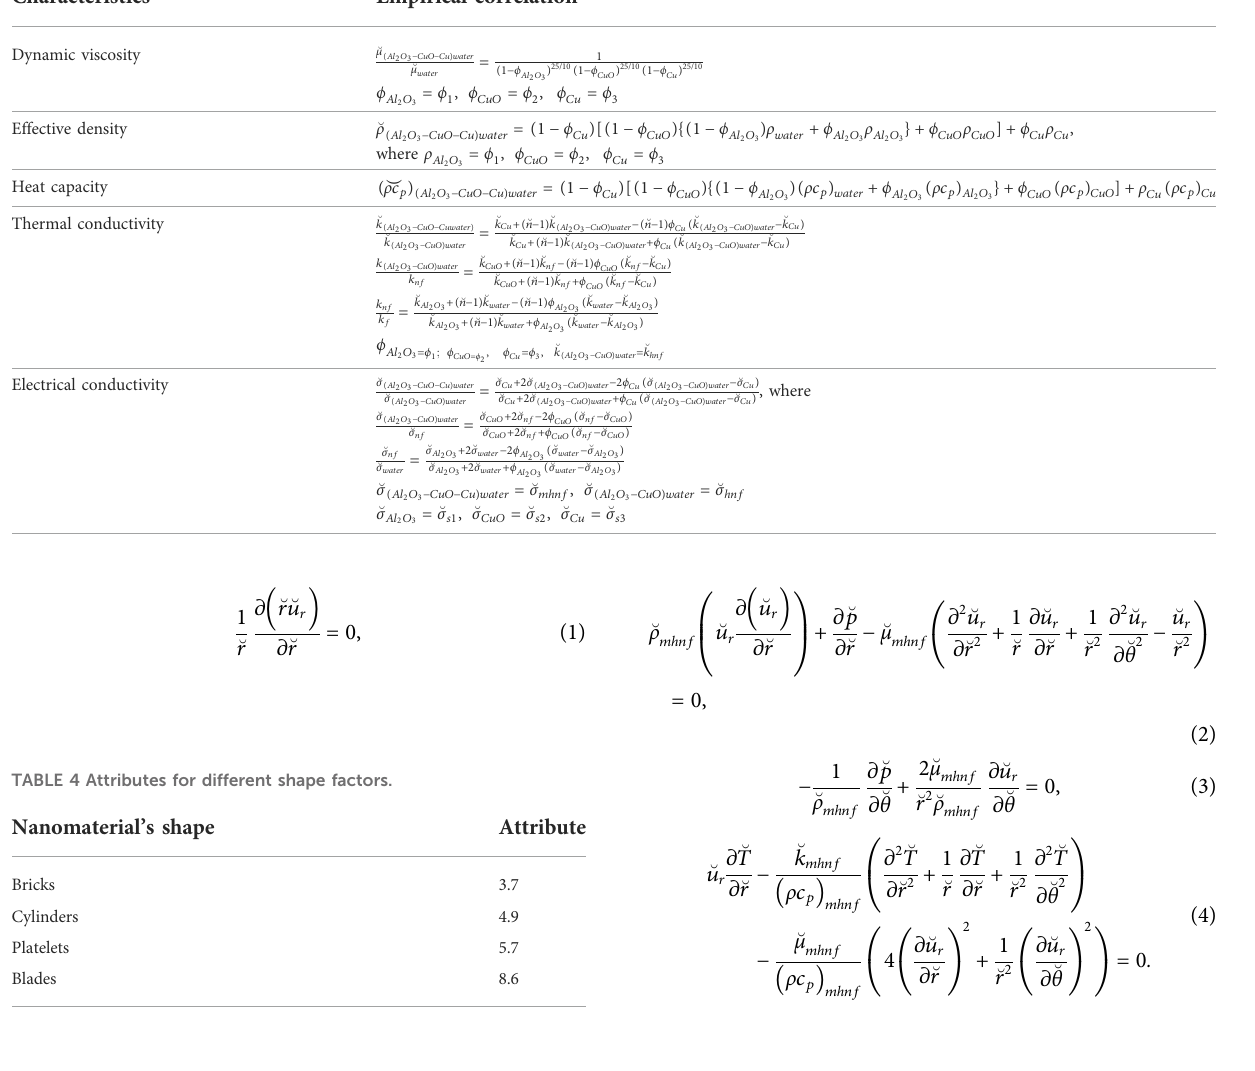
TABLE 3 Empirical correlations for third-generation heat transfer fl uids (modi fi ed hybrid nano fl uids).